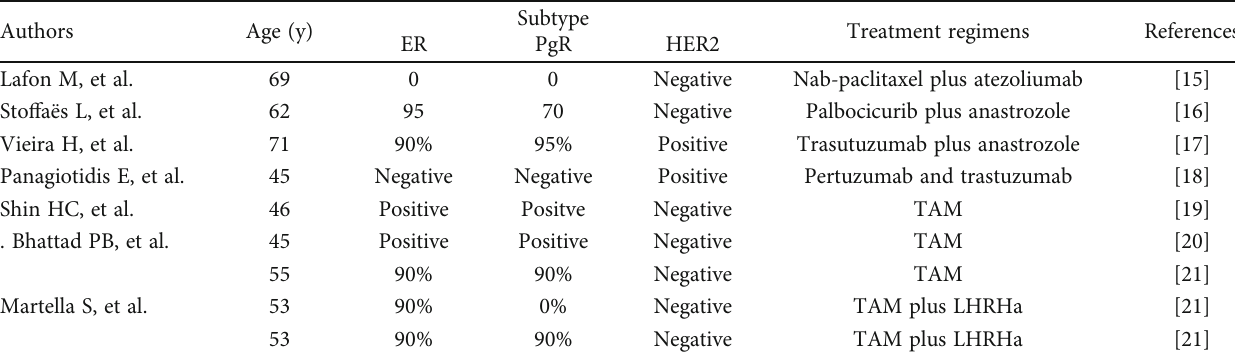
Figure 2: Exploration of subcutaneous mass in the lower extremities. Hematoxylin and eosin stain shows epithelioid cell granuloma with Langhans giant cells. There are no necrotic tissue and no similarity to surgical specimens of breast cancer. Table 2: Published reports of SLR in patients with breast